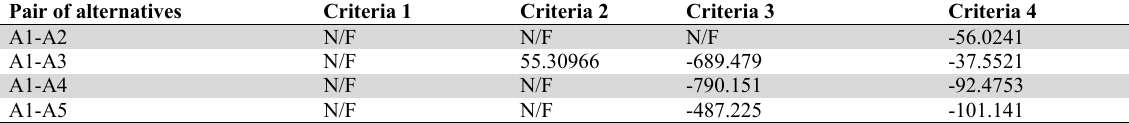
Fig. 6. Ranking of alternatives for different distinguishing coefficients